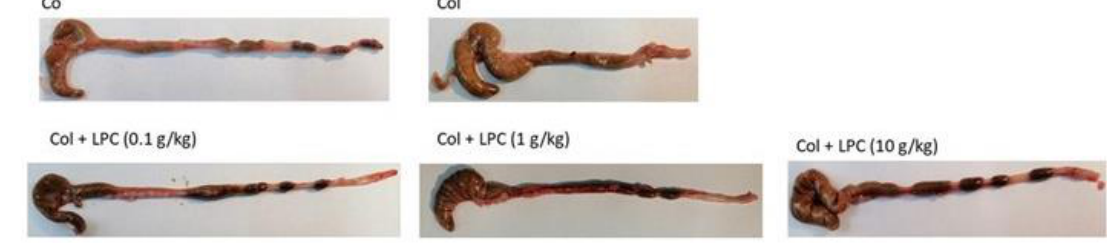
Figure 1. Representative images of the effect of a 4-day lupin concentrate feed in TNBS-induced colitis in mice. LPC was administered orally in three different concentrations (0.1, 1 and 10 g/kg). Co: control group (healthy); Col: colitis group; Col + LPC: colitis group fed with LPC (at each concentration). Table 2. Effect of a 4-day lupin concentrate feed in TNBS-induced colitis in mice. Disease activity index (DAI) determined as the average of the score of weight loss and stool consistency; average colon length (cecum until rectum), represented in cm; MMP-9 activity measured by the DQ-gelatin kit. Co: control group (healthy); Col: colitis group; Col + LPC: colitis group fed with LPC (at each concentration). Non-parametric data are expressed as the mean and respective maximum and minimum levels, and parametric data are expressed as medium ± SD. (* p < 0.05, ** p < 0.001 in relation to colitis and # p < 0.05 in relation to